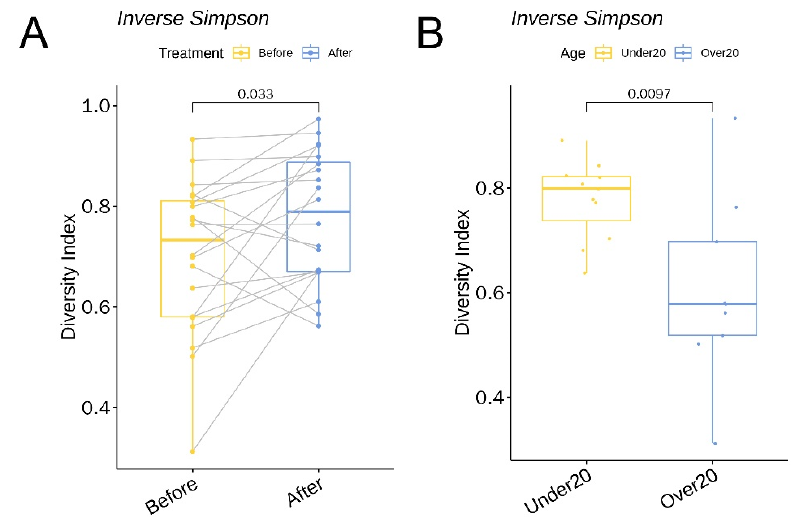
Figure 9. A boxplot of the inverse Simpson index ( A ) comparing skin microbiota before and after treatment and ( B ) comparing baseline skin microbiota in patients under 20 and over 20 years.